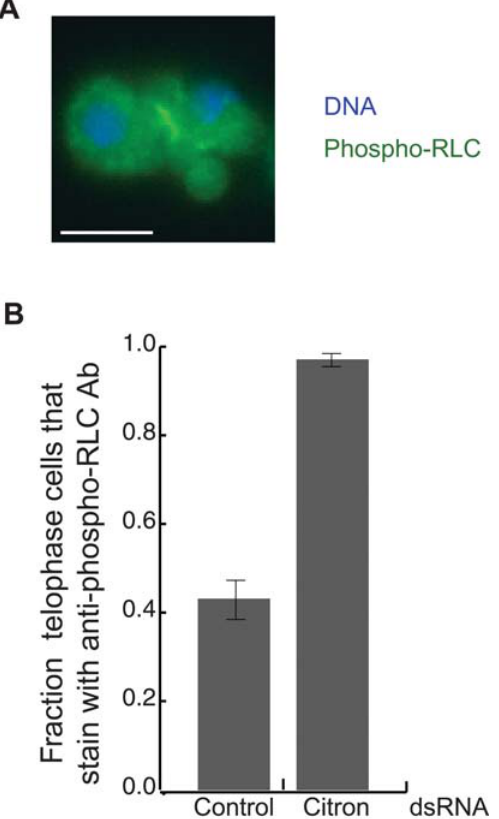
Figure 4. Citron is not essential for RLC phosphorylation . (A) Immunofluorescent localization of DN A (blue) and phospho-RLC (green) in Citron depleted cells. Notice the membrane blebs in the telophase furrow as well as the anti-phospho-RLC antibody staining in the midbody. Scale bar=5 m m. (B) Depletion of Citron probably affects the structure of telophase midbodies. S2 cells were depleted of Citron by treatment with RNAi for 5 days and then fixed and stained with an anti-phospho-RLC antibody. Late telophase cells were scored for antibody staining (mean, 6 SE for 30 cells). While less than half of all control cells were stained, nearly all Citron depleted cells were